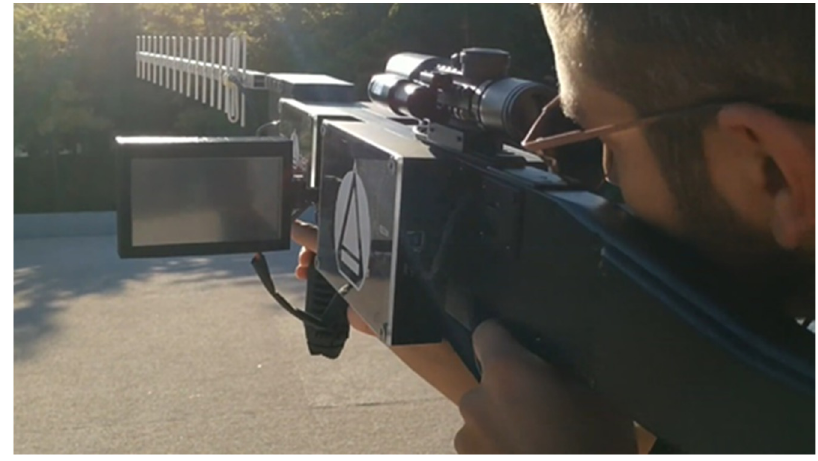
Figure 14. Anti-UAV mobile system operator. ×